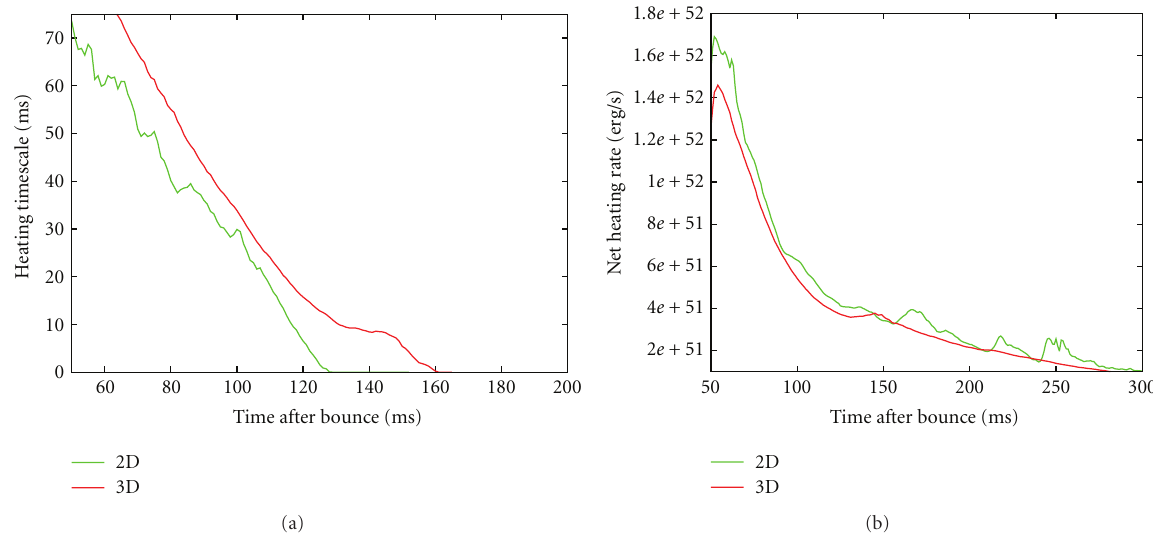
Figure 8: Time evolution of neutrino-heating timescale (left) and total net rate of neutrino heating (right) in our 2D (green line) and 3D models (red line). These figures are taken from